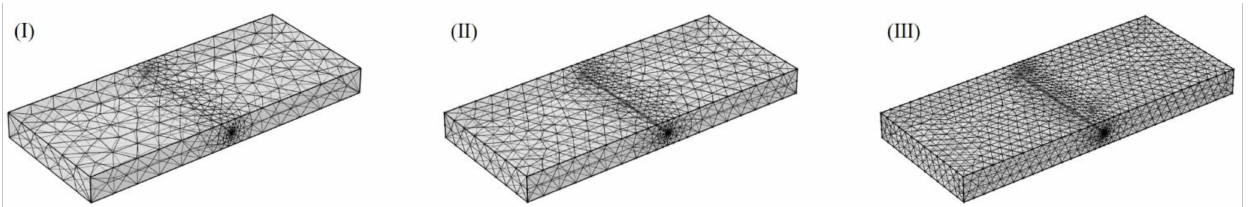
Figure 7. Mesh division types: ( I ) normal; ( II ) fine; ( III ) finer.